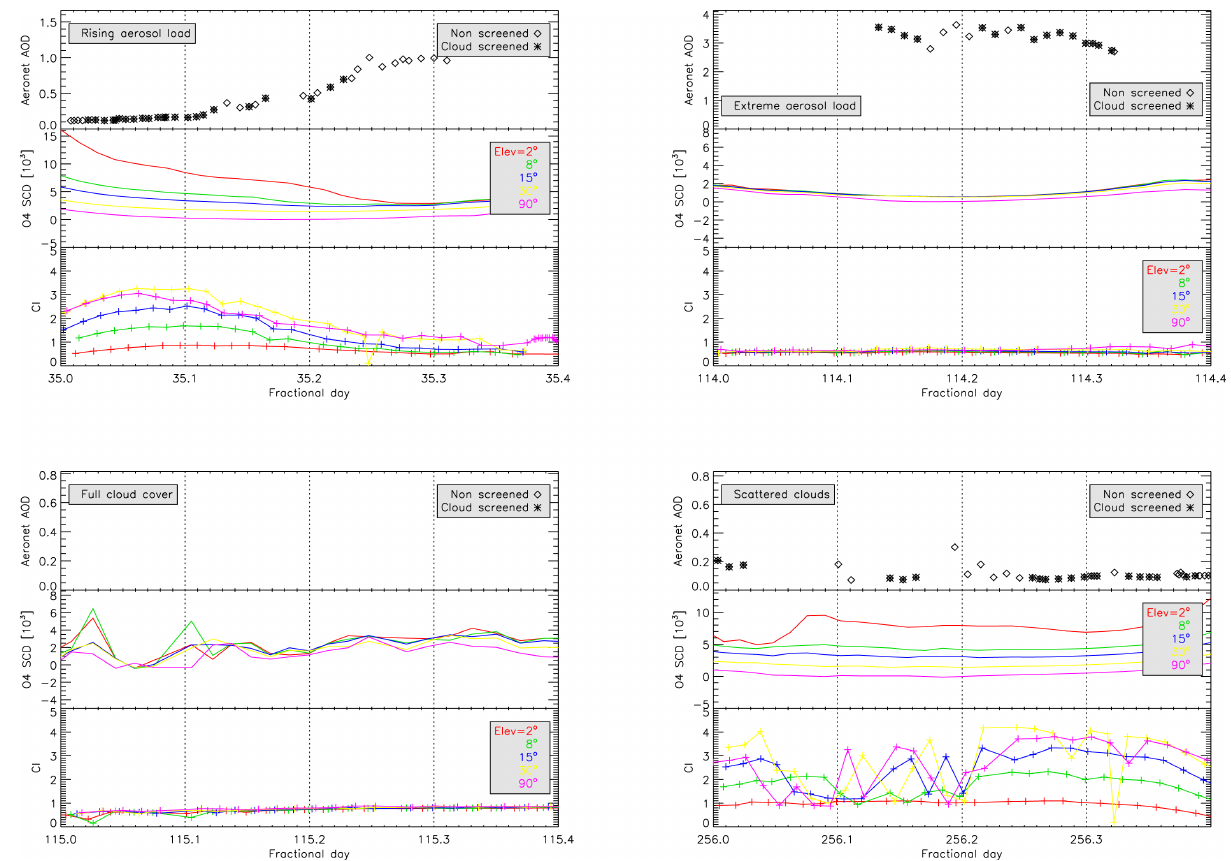
Figure 1. Comparison of 4 days at Xianghe with distinct meteorological conditions. The top box shows the measured AERONET AOD at 477nm, both the non-screened (level 10) and cloud-screened (level 15) data, the middle box the measured MAX-DOAS O 4 DSCDS (in units of 10 40 molec 2 cm − 5 ) and the bottom box the calculated colour index. Different colours represent the different MAX-DOAS elevation angles. Fractional day is always given in UT time.